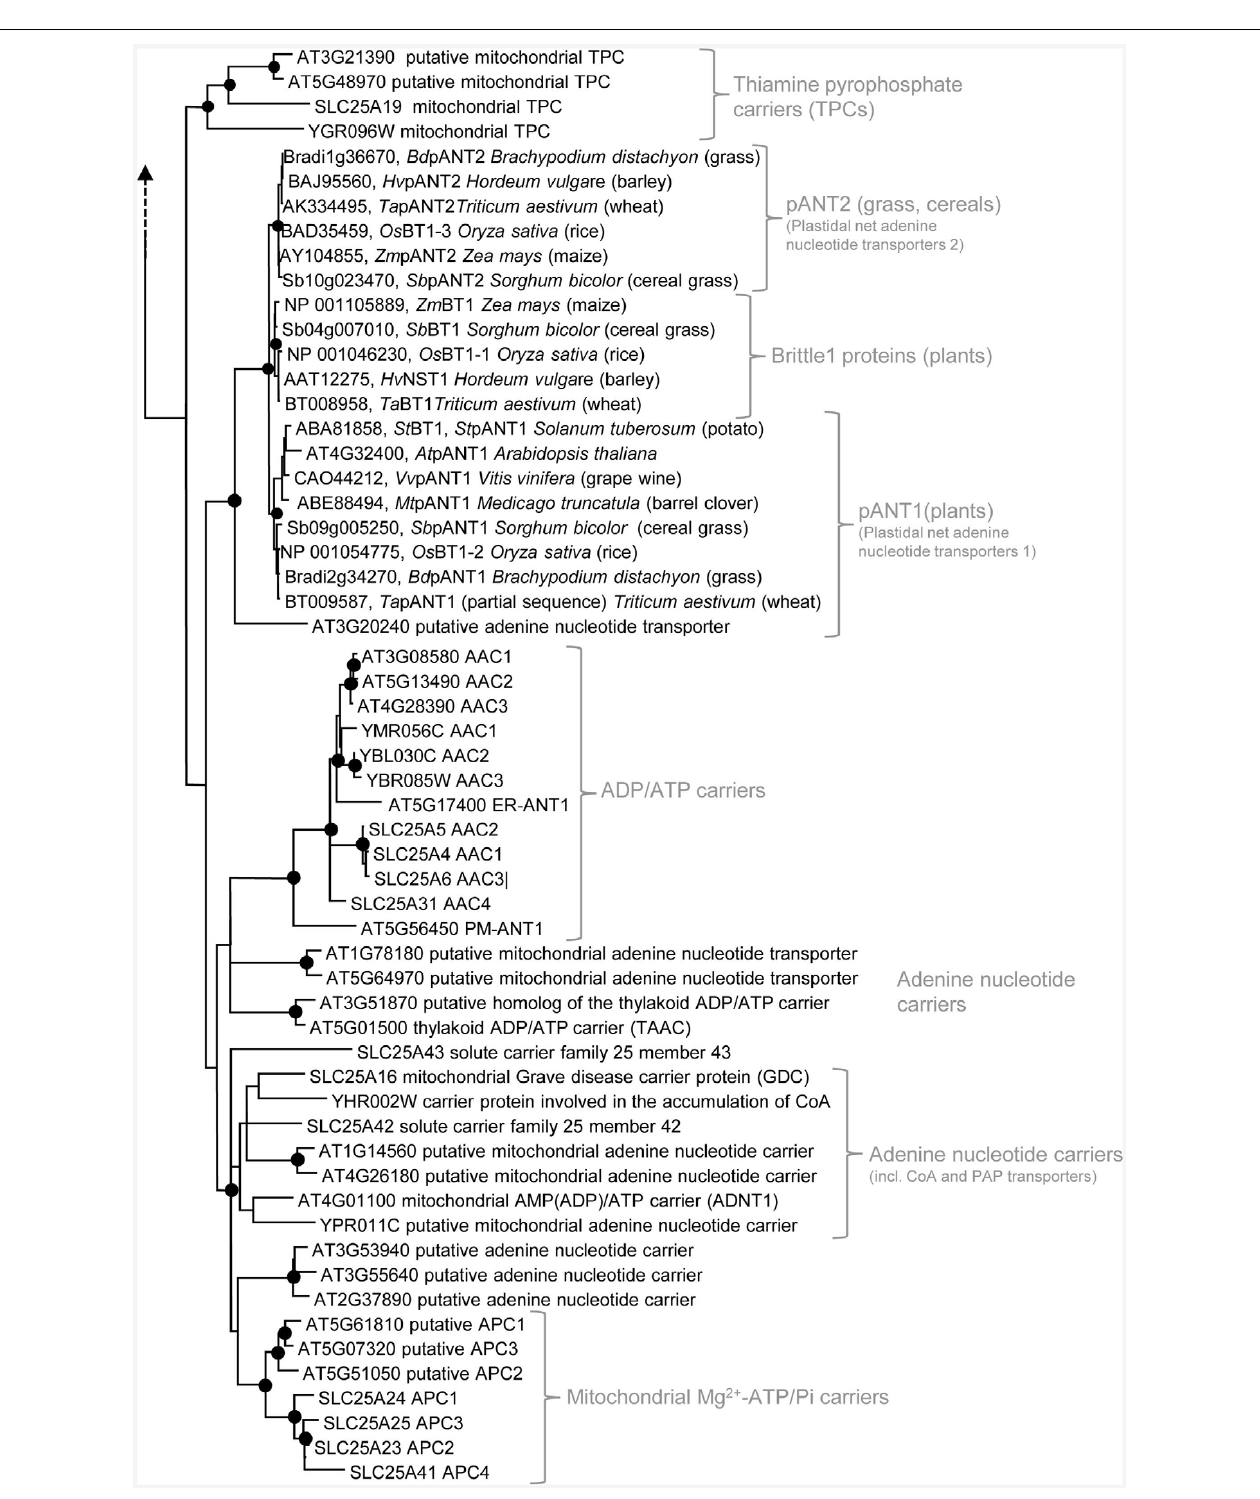
Mg2 + –ATP/Pi carrier (Sallp) is included in the subset of FigureA3 ]. Nodes that are supported by bootstrap values (maximum likelihood and maximum parsimony, 1000 replications) higher than 70 are indicated by black